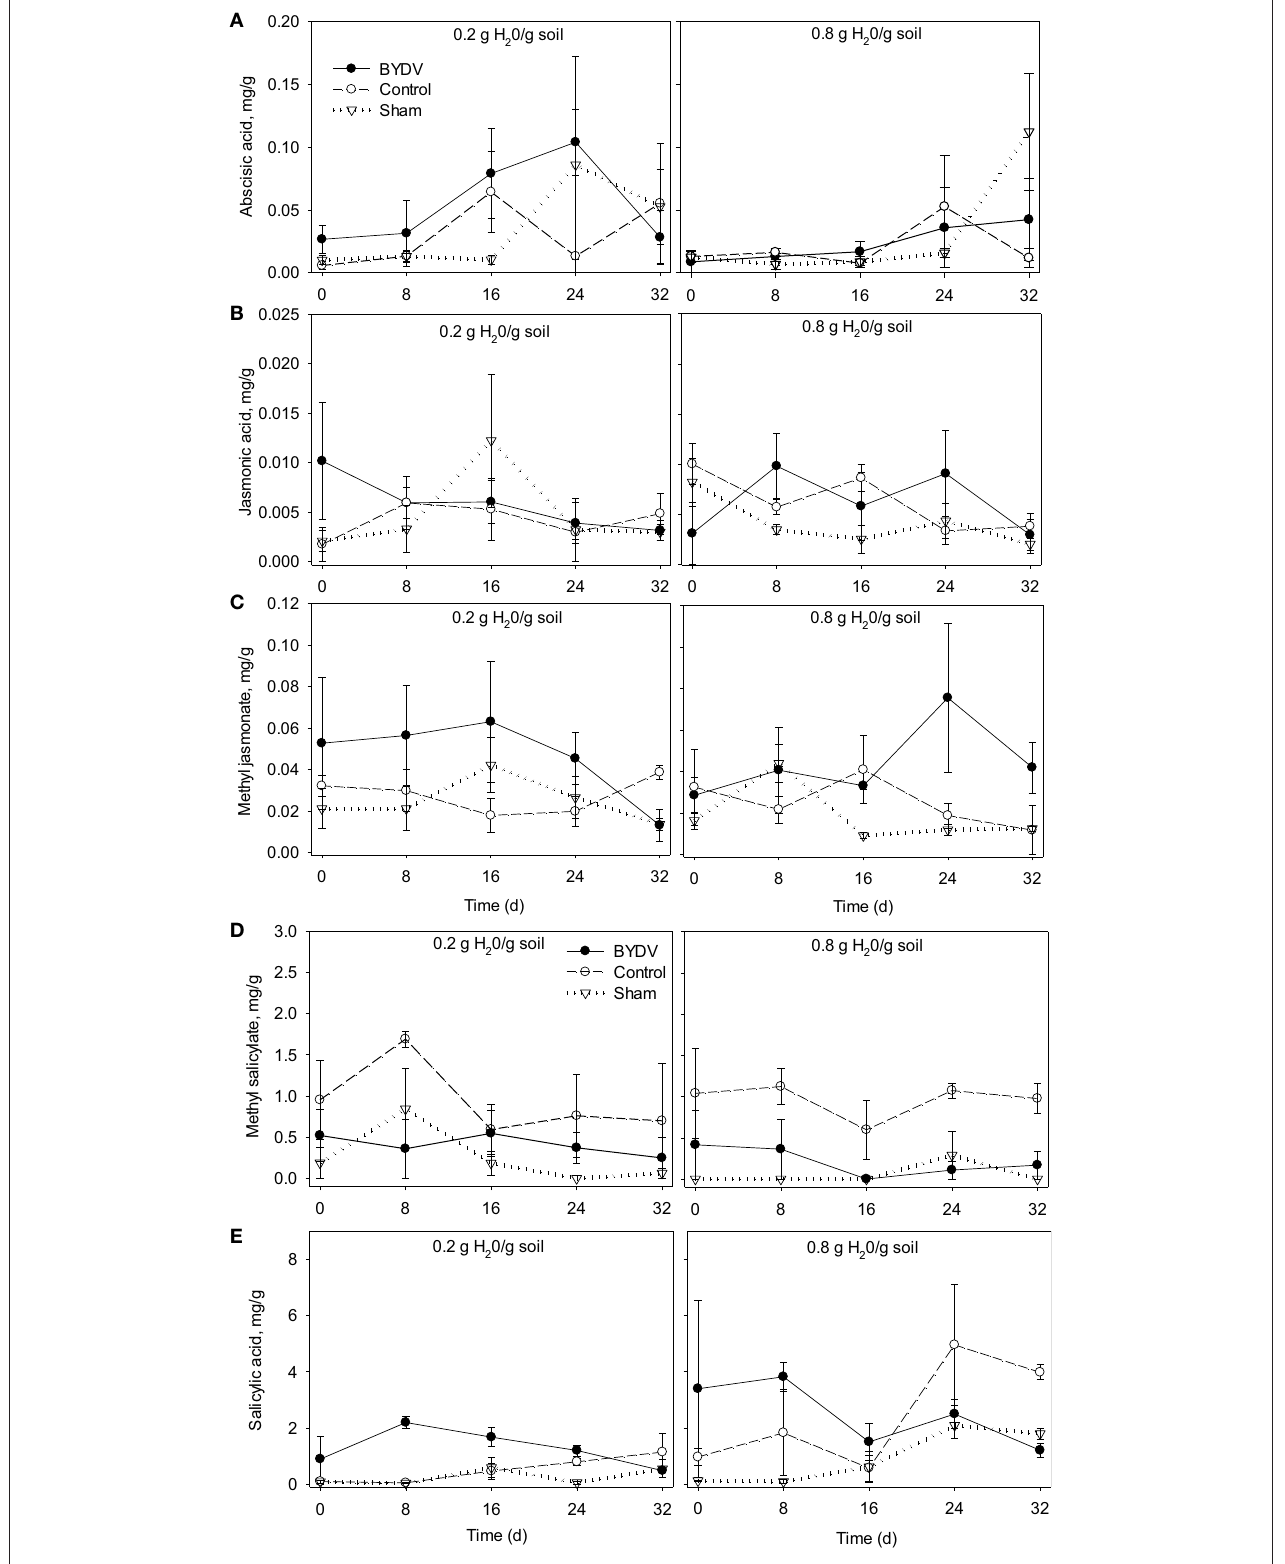
FIGURE 2 | Time series showing changes in mean concentrations of (A) abscisic acid, (B) jasmonic acid, (C) methyl jasmonate, (D) methyl salicylate, and (E) salicylic acid in wheat leaf tissues in response to two watering treatments (0.2 and 0.8g H 2 0/g soil) and three virus infection treatments (BYDV, sham treatment, and nondamaged control). Bars show one standard error of the mean. Frontiers in Ecology and Evolution |